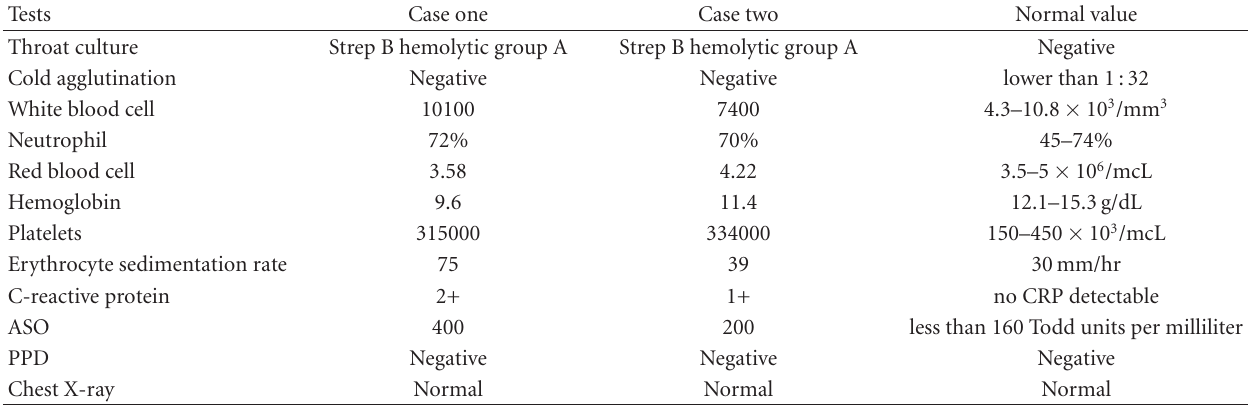
Table 1: Laboratory data of the two cases.